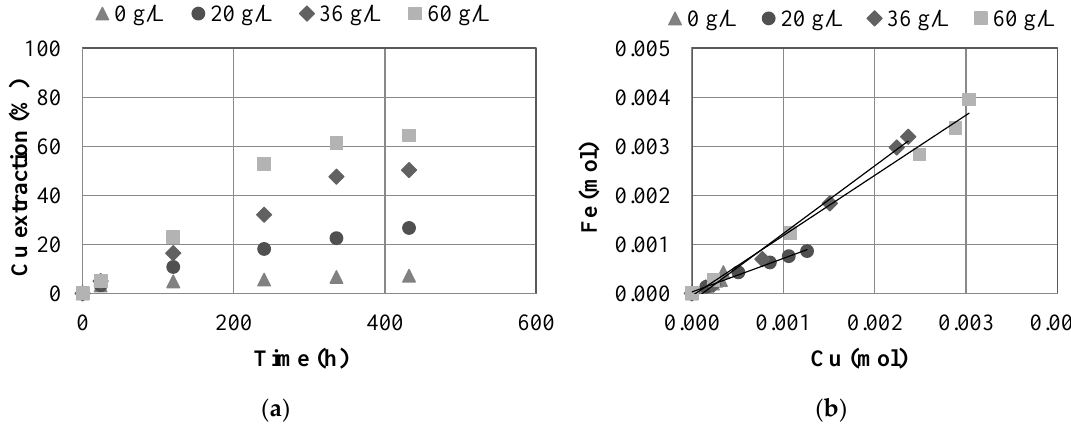
Figure 7. ( a ) Copper extraction (%) versus time (h) at di ff erent chloride concentration: 0, 20, 36 and 60 g / L. ( b ) Cu / Fe molar ratio at di ff erent chloride concentration: 0, 20, 36 and 60 g / L. Experimental conditions: [NaNO 3 ] = 0.7 M, [H 2 SO 4 ] = 0.7 M, − 150 + 75 µ m, S / L ratio 2 g / L, 45 ◦ C, 350 rpm, sample